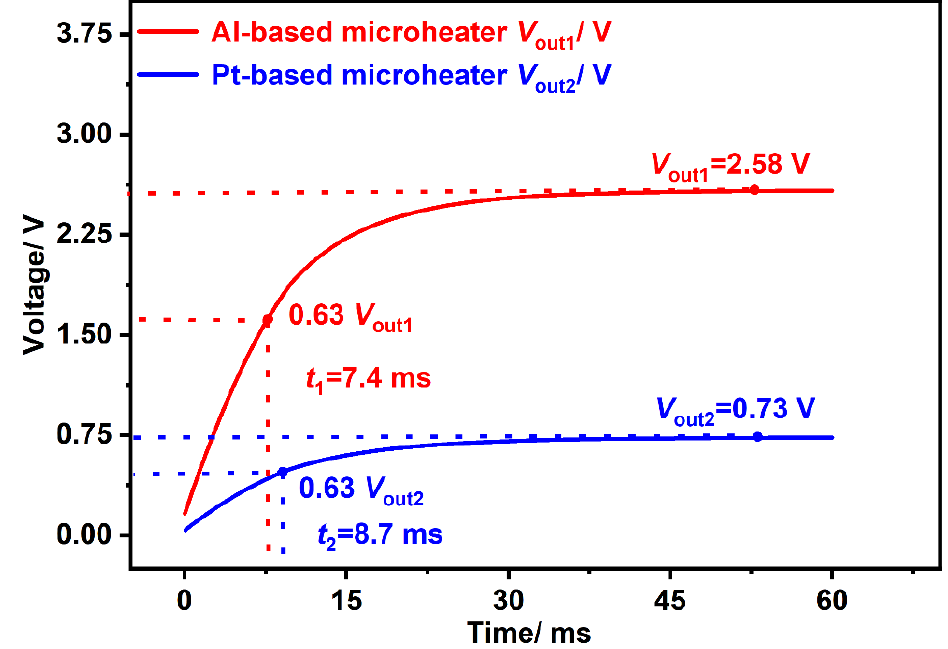
Figure 5. Simulated output voltages and response times of the same device embedded with an Al — based microheater and a Pt — based microheater.